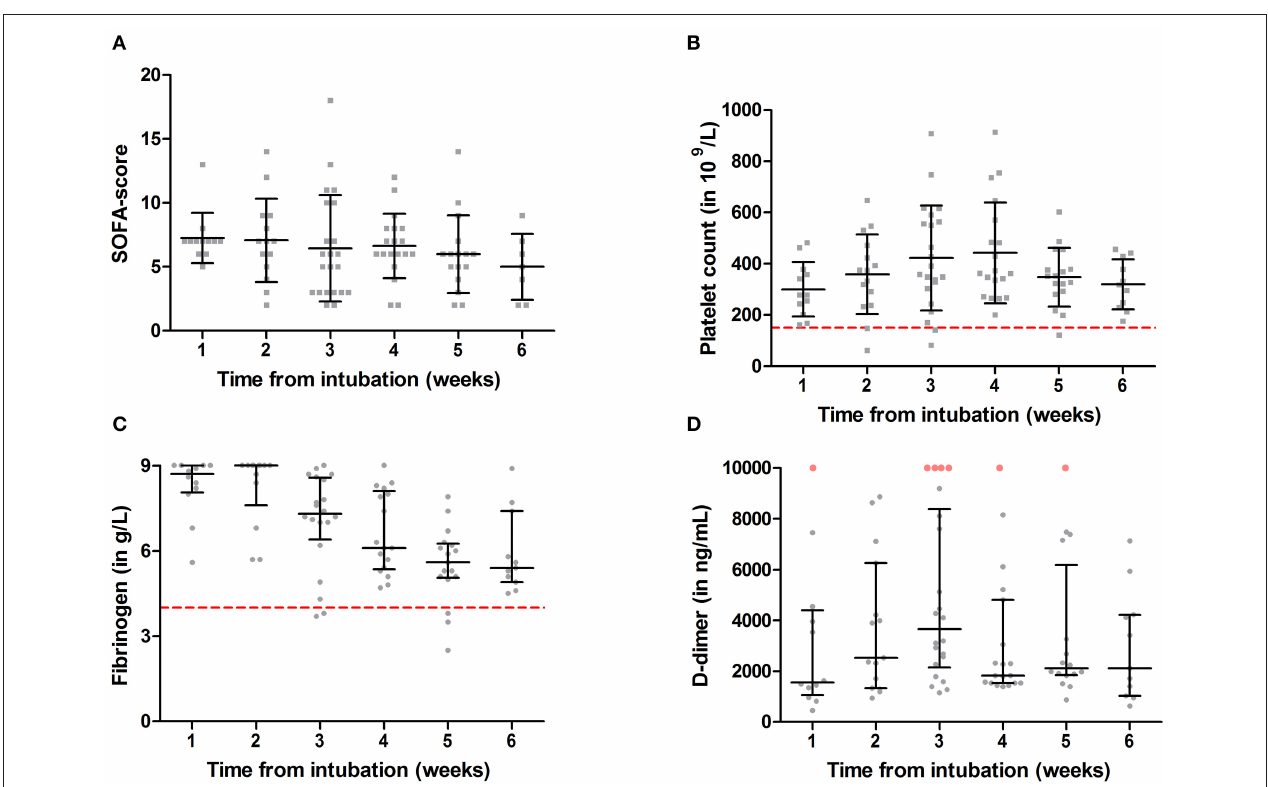
FIGURE 1 | Sequential Organ Failure Assessment (SOFA) score (A) , platelet count (B) , D-dimer (C) , and fibrinogen (D) measurements over 6 weeks from intubation in a critically ill COVID-19 population. Results are presented as mean with standard deviation ( (cid:4) ) or median with interquartile range ( • ); gray symbols illustrate individual measurements. Dashed lines represent reference values for thrombocytopenia ( < 150 × 10 9 /L) and hyperfibrinogenemia ( > 4 g/L). D-dimer reference range is age dependent and is defined as < 500, < 510, < 560, < 610, < 660, and < 710ng/ml for ages < 50, 51–55, 56–60, 61–65, 66–70, and 71–75, respectively. Red dots illustrate D-dimer values > 10,000